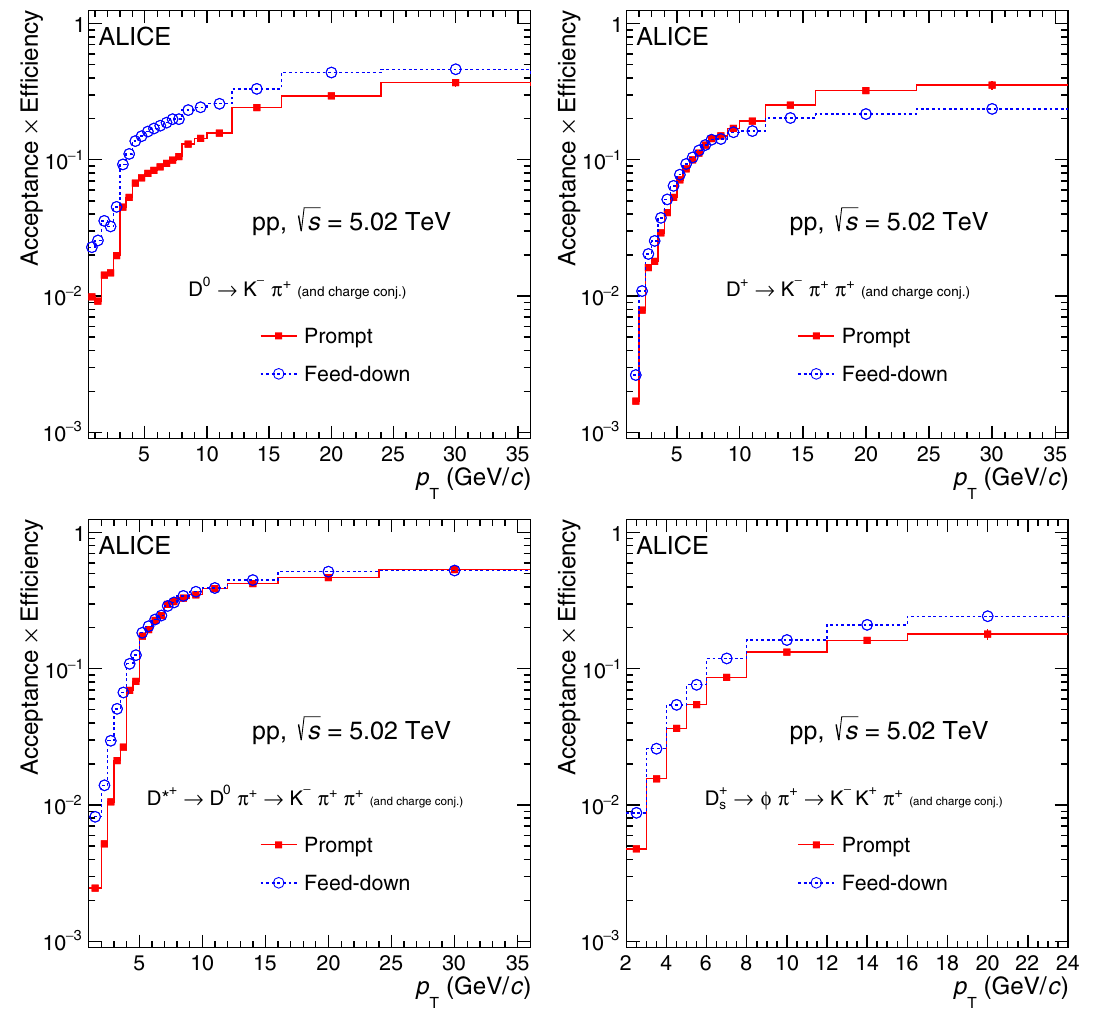
Fig. 2 Acceptance × efficiency for D 0 , D + , D ∗+ , and D + s mesons, as a function of p T . The efficiencies for prompt (solid lines) and feed-down (dotted lines) D mesons are shown